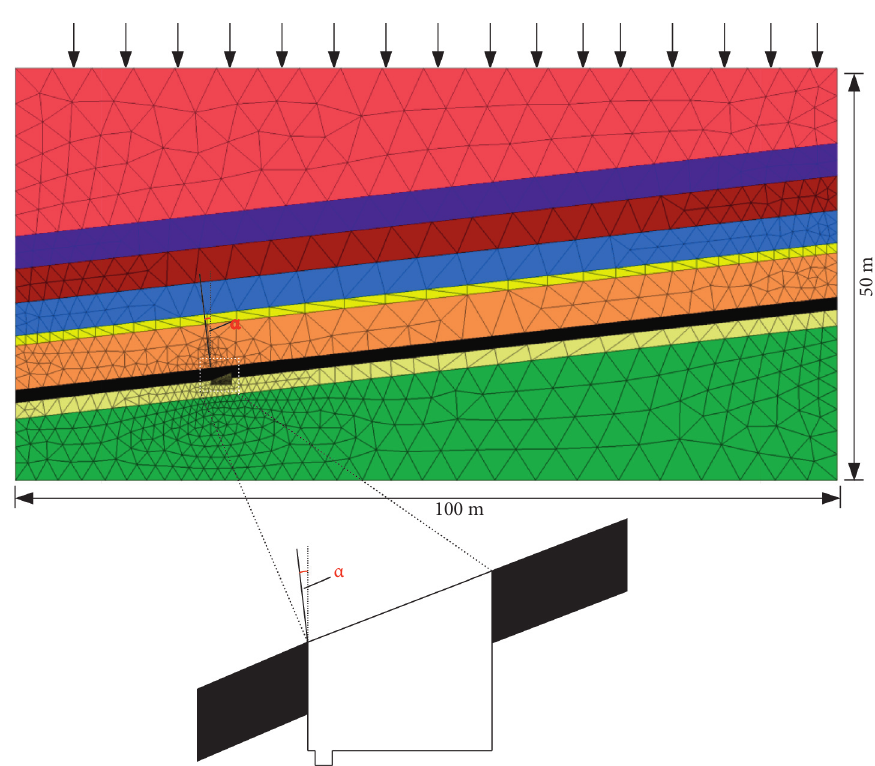
Figure 2: Numerical simulation